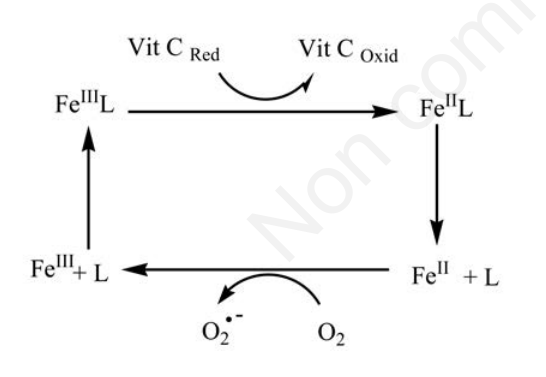
Figure 5. Redox cycling of an iron complex.